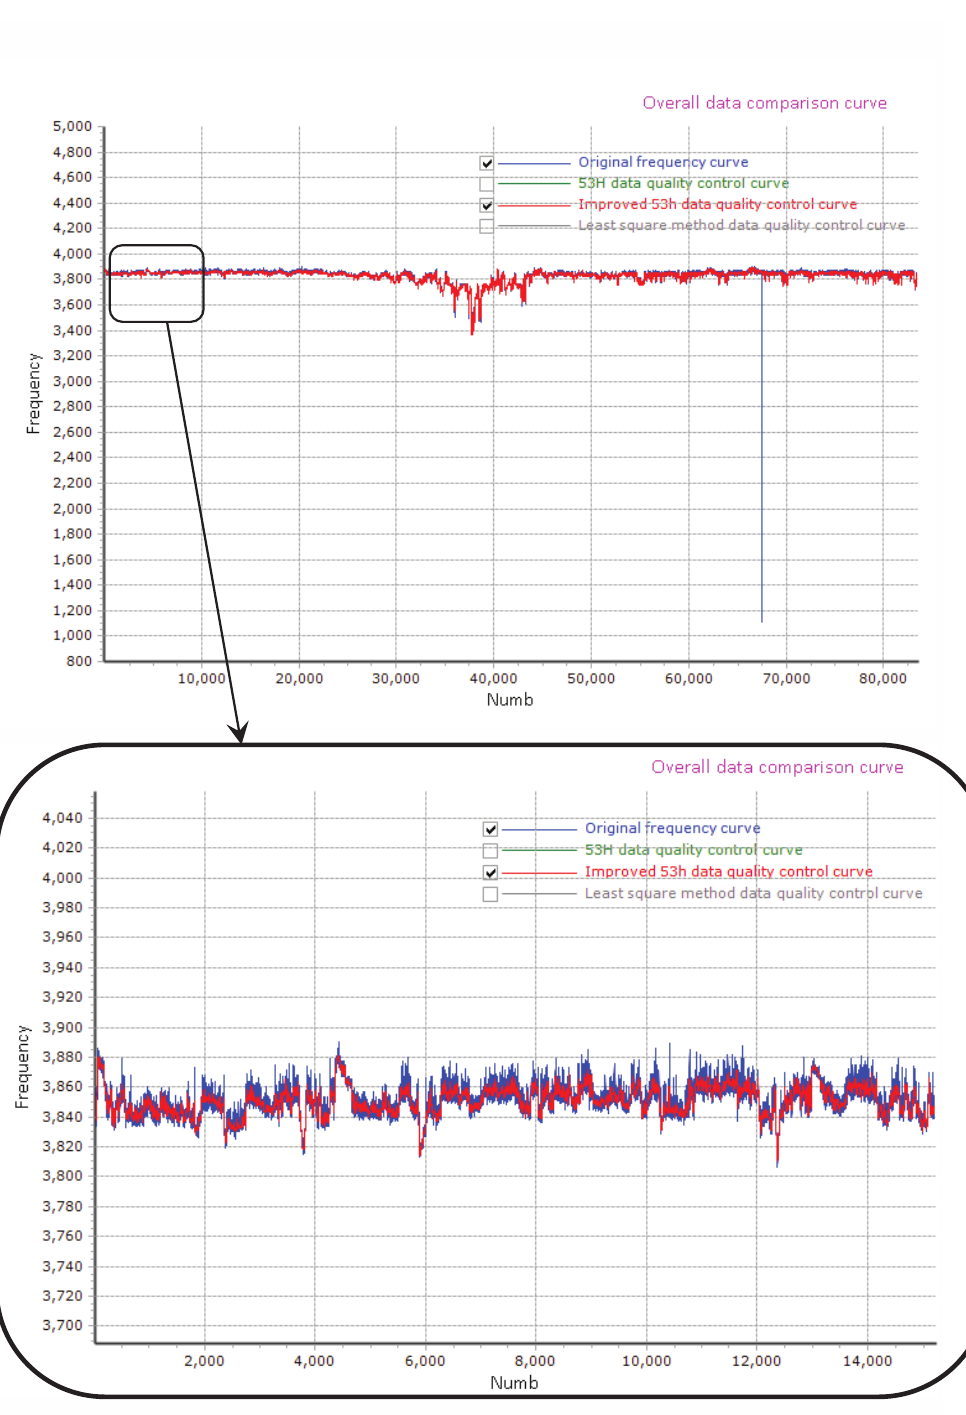
Figure 13. The filtering results of the improved 53H